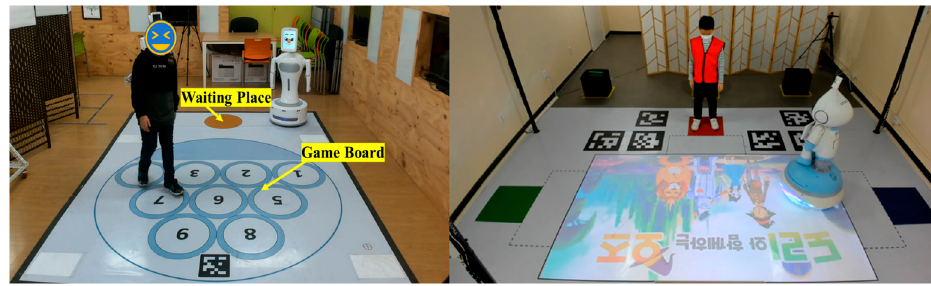
Figure 15. Data acquisition environments in Session 1 (left) and Sessions 2 and 3 (right).